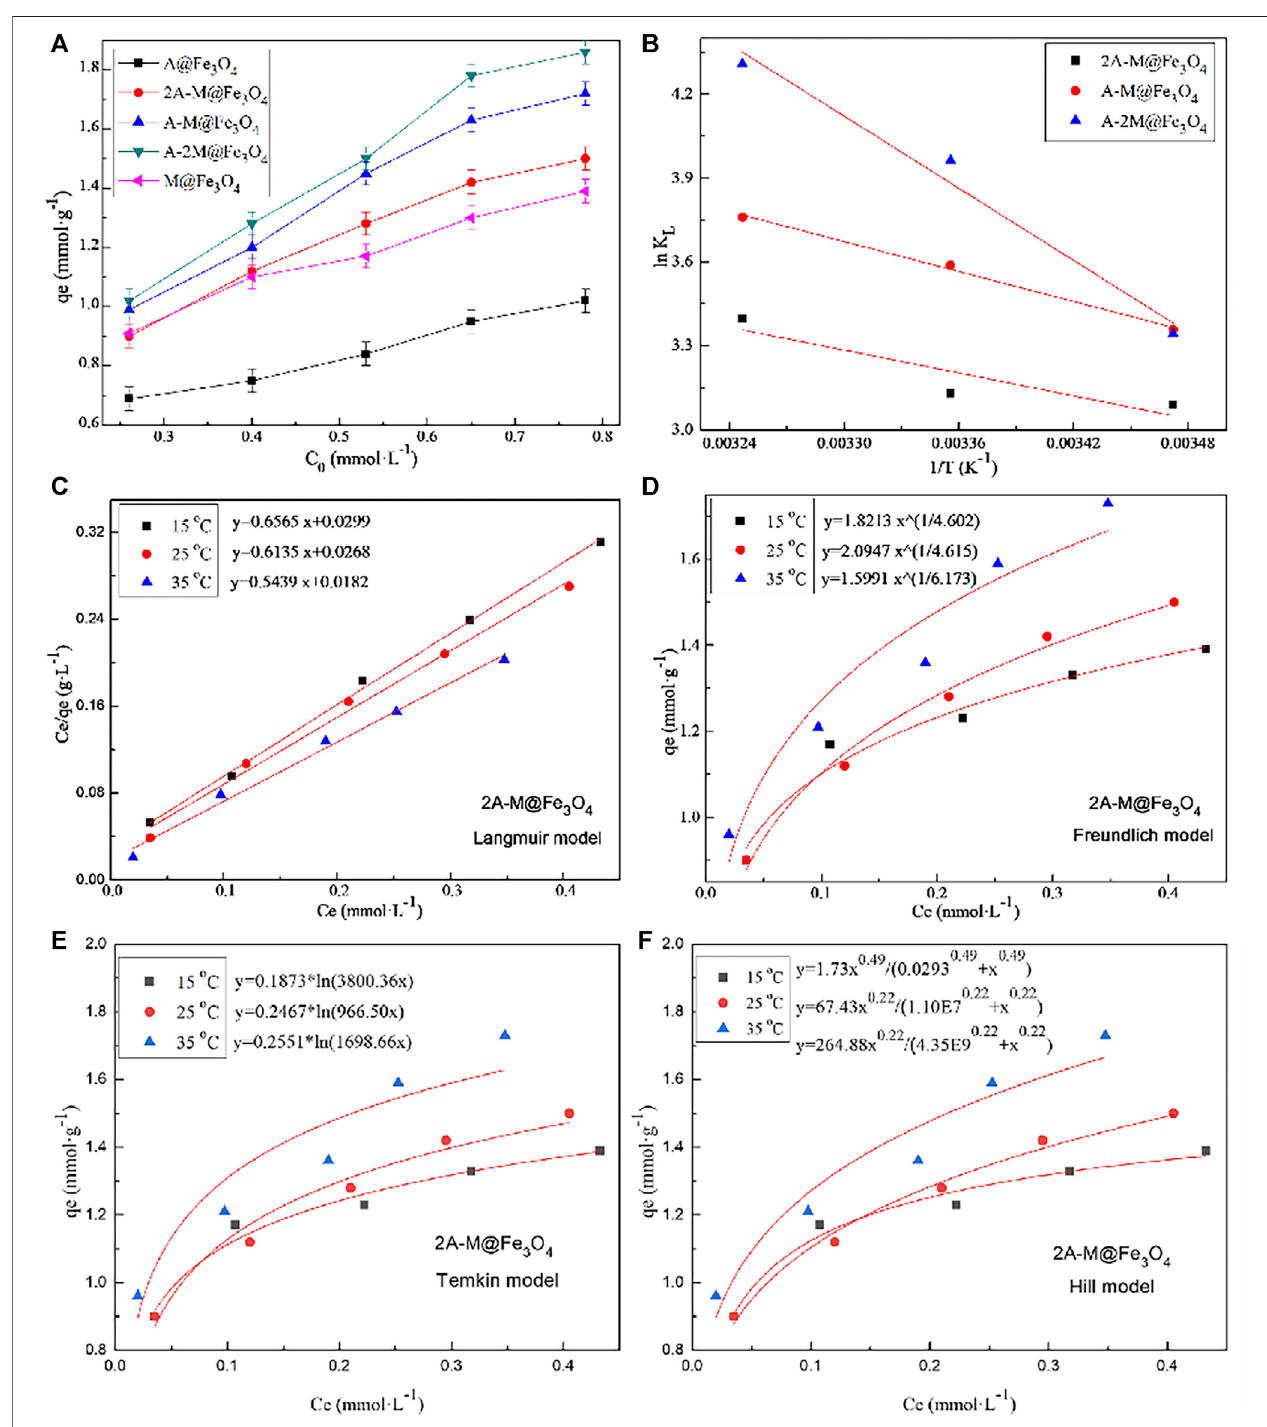
FIGURE 3 | (A) The adsorption capacities of composites for Hg(II) varies with initial concentration at pH 4.5 and 25 ° C; (B) the ln K L ∼ 1/T lines of bifunctional composites for Hg(II); (C) Langmuir, (D) Freundlich, (E) Temkin, and (F) Hill fi tting curves of 2A-M@Fe 3 O 4 for Hg(II) at different temperatures.